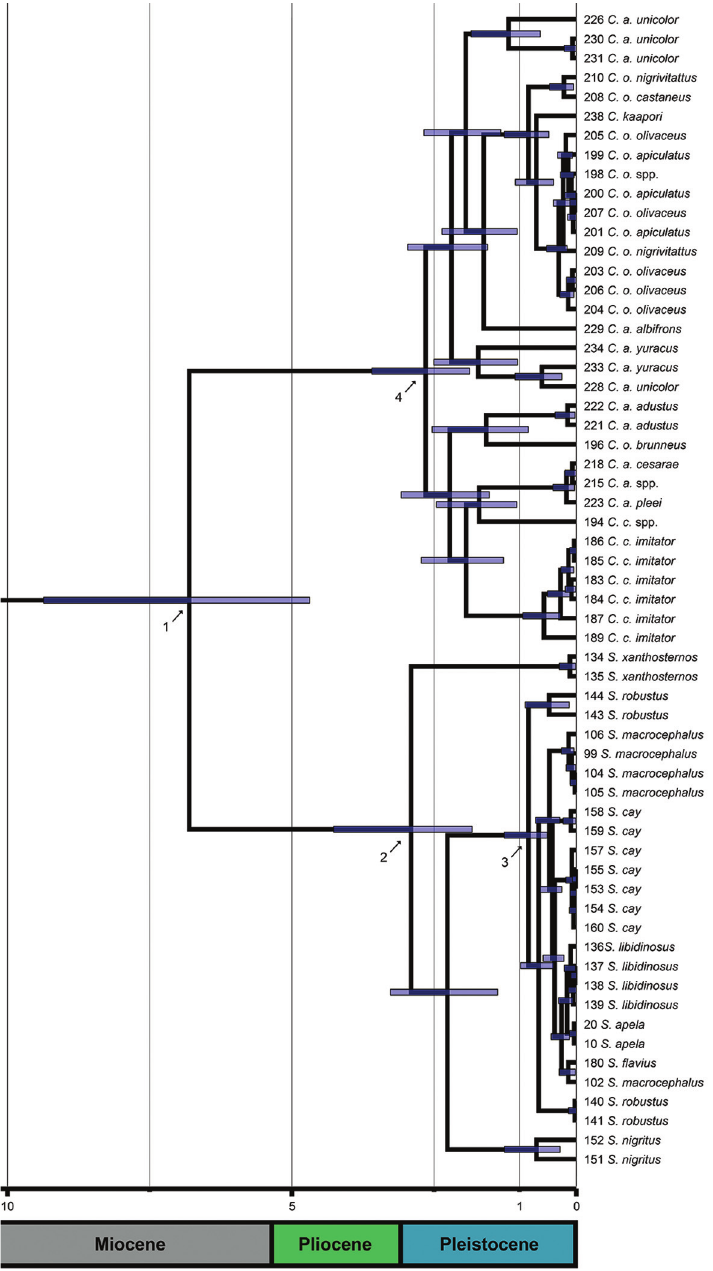
Figure 3 - Divergence time tree of capuchins estimated on BEAST 1.8.3. Nodes were calibrated using the age of four Platyrrhini fossils. The blue bars above the nodes indicate the Highest Posterior Density of the estimated ages. Arrows 1, 2, 3 and 4 represent the split of the crown capuchins, the first split of the crown Sapajus , a recent split within Sapajus (~ 1.0 Ma) and the first split of the crown Cebus , respectively. The lower boxes indicate the geological times of the Cenozoic